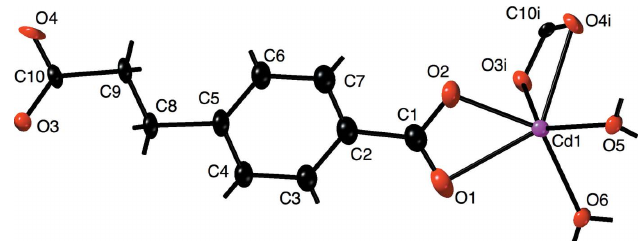
Figure 1 The coordination environment of the Cd II atom, showing trigonal– prismatic coordination. Displacement ellipsoids are drawn at the 50% probability level. H atom positions are shown as sticks. [Symmetry code: (i) x (cid:5) 1 , (cid:5) y + 1 , z (cid:5) 1 2 2 2